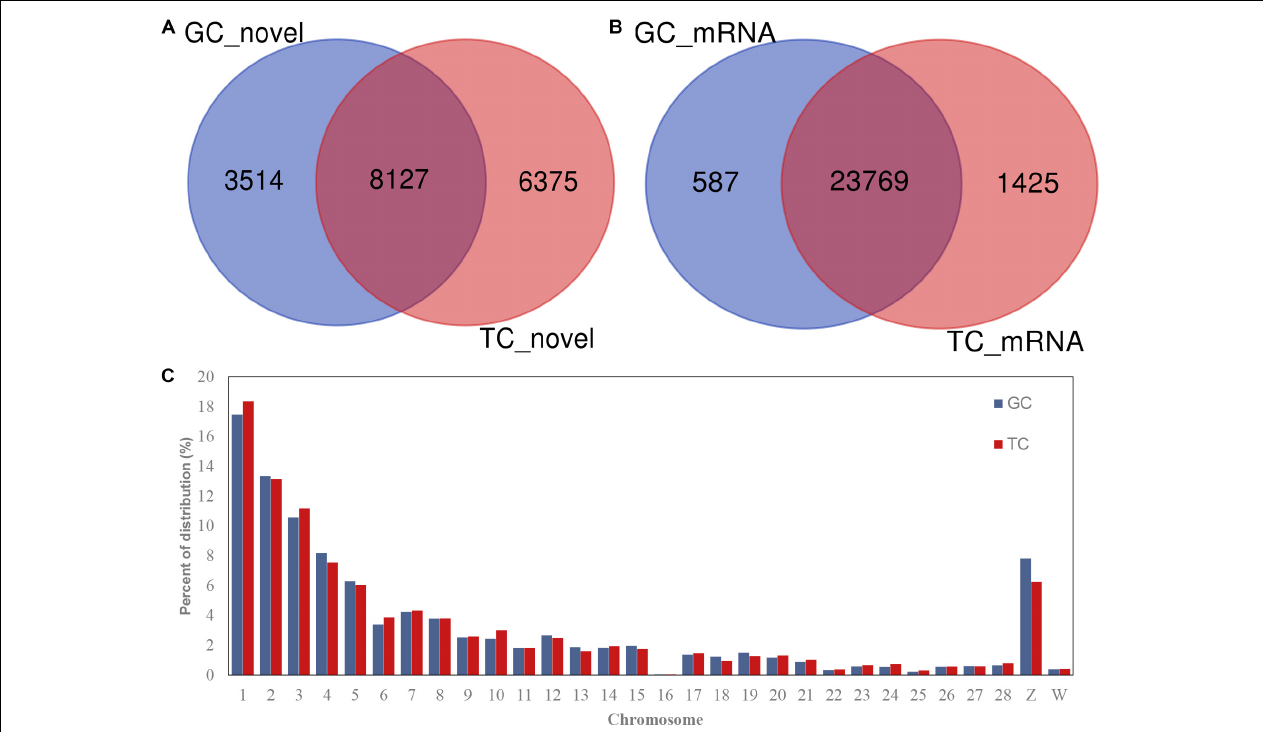
FIGURE 1 | circRNAs and mRNAs detected in GCs or TCs. (A) Novel circRNAs detected in GCs and TCs; (B) mRNA identified in GCs and TCs; (C) circRNA distribution on chromosome. GCs, granulosa cells; TCs, theca cells.